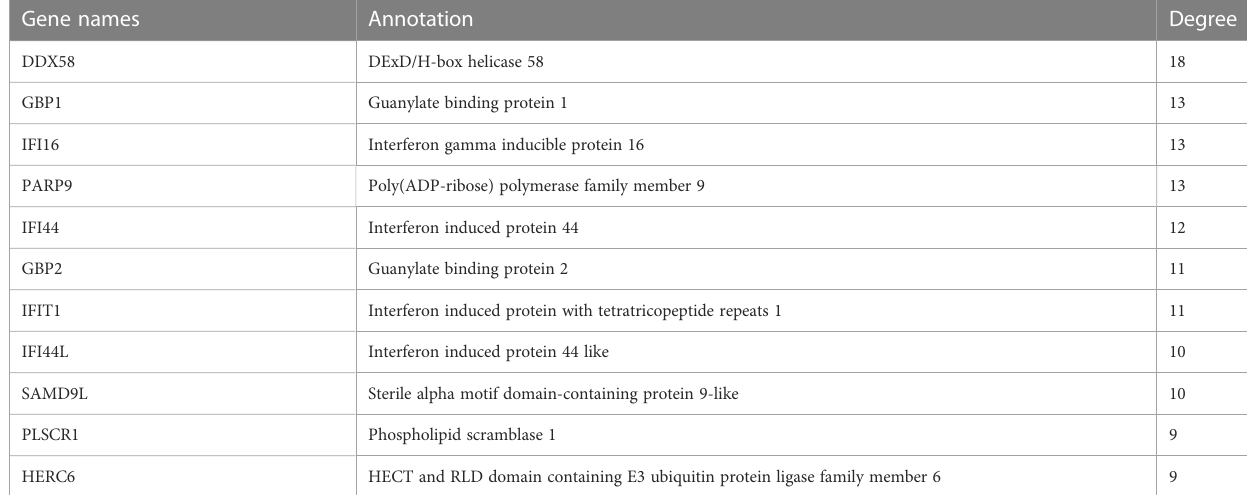
TABLE 3 Topological analysis results by degree — The third Protein-protein interaction networks in MCODE analysis. Gene